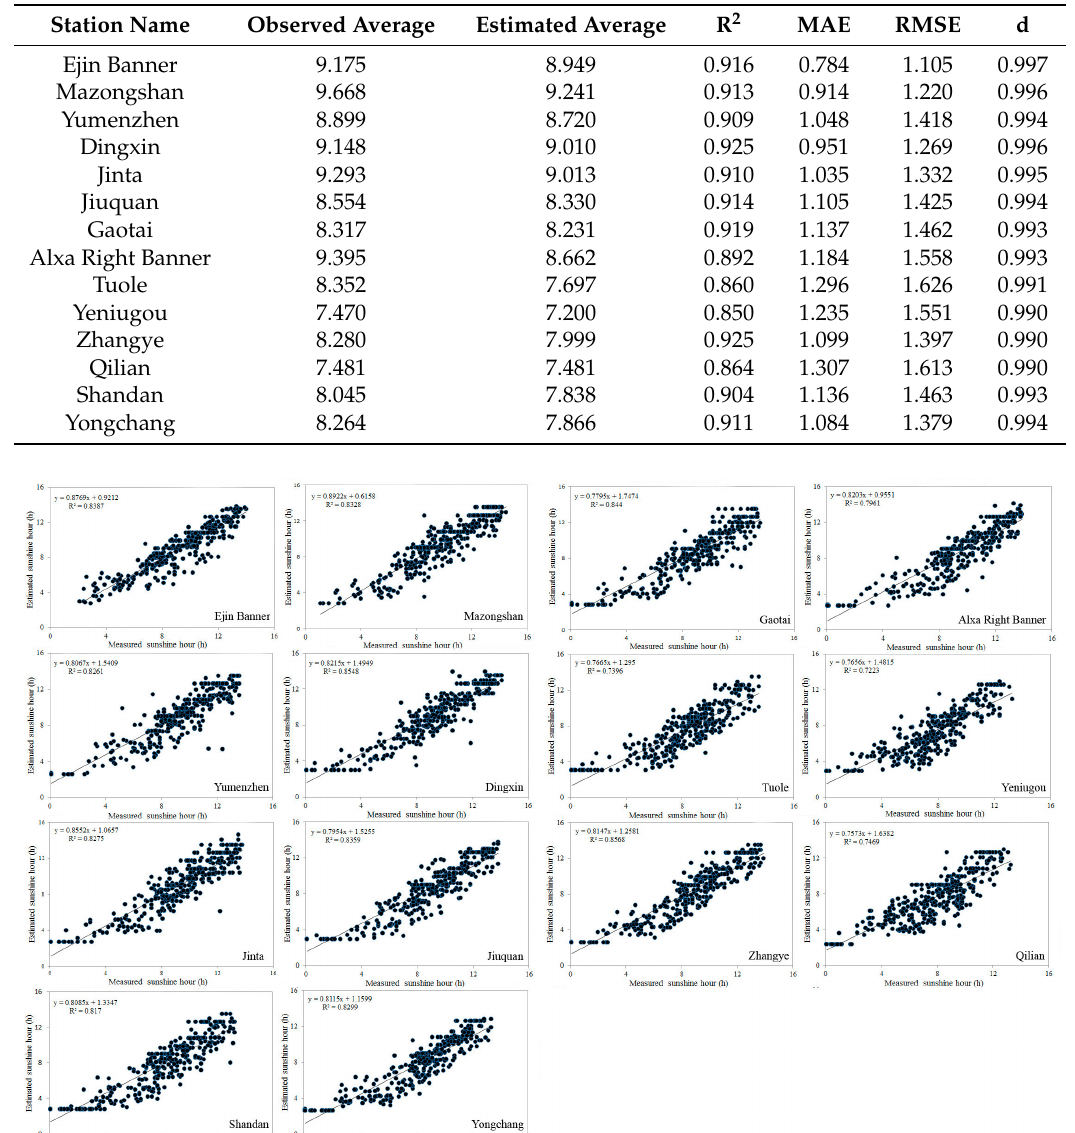
Table 5. Validation results of the estimation of daily sunshine duration over the Heihe River Basin.